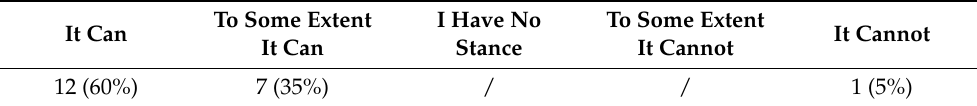
Table 4. Analysis of the given answers to the final question: By analyzing Figure 13b, does this smart visualization (SVMI) of the medical images of a patient’s brain contribute to the education of MDs